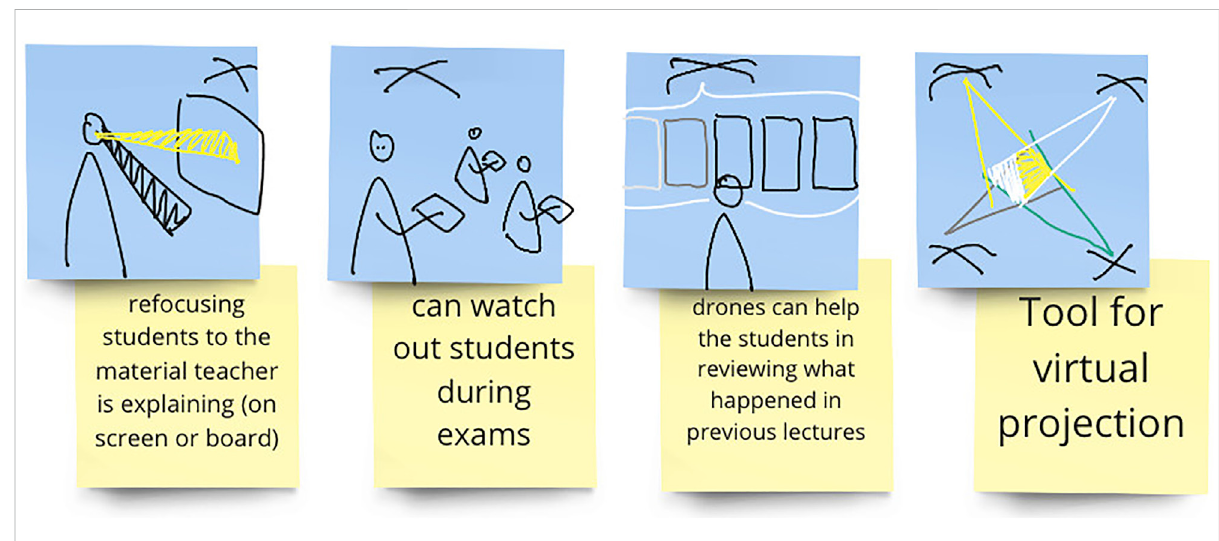
FIGURE 4 An example of the drawings made by the sketch artist to visualize participants ’ written ideas during the fourth workshop. The hovering X shape illustrates a drone. The shape representing the drone was suggested by the sketch artist during the pilot study, to allow the visualization of drones in the quickest way